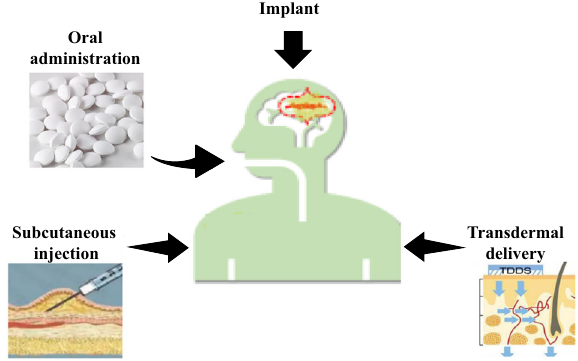
Fig. 6 Various routes of drug